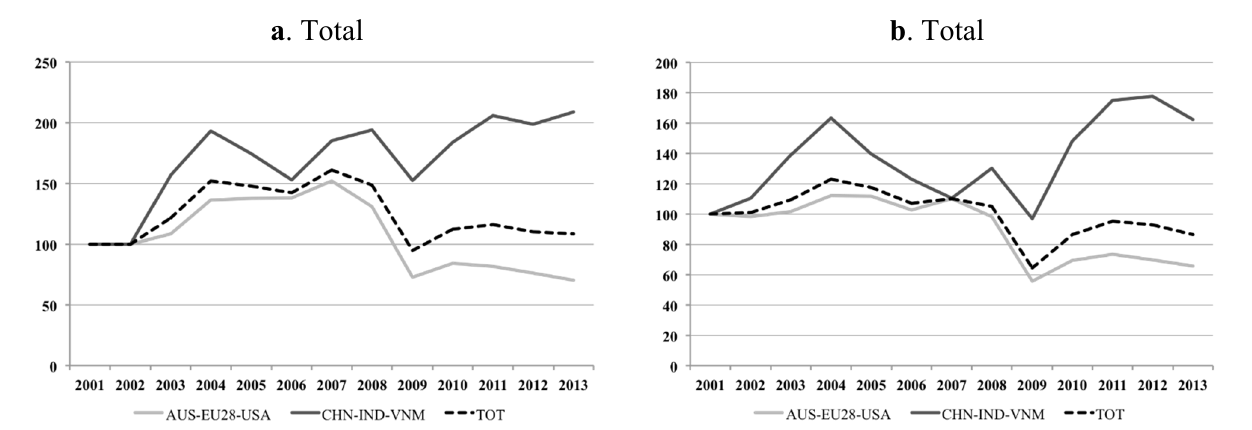
Figure B5. Evolution of tropical timber product imports by groups of selected countries, in values indexed to 2001 (2001 = 100): ( a ) total imports and ( b ) imports from VPA countries (2001–2013). AUS = Australia; CHN = China; EU-28 = European Union; IND = India; USA = United States of America; VNM = Vietnam. Source: own elaboration from